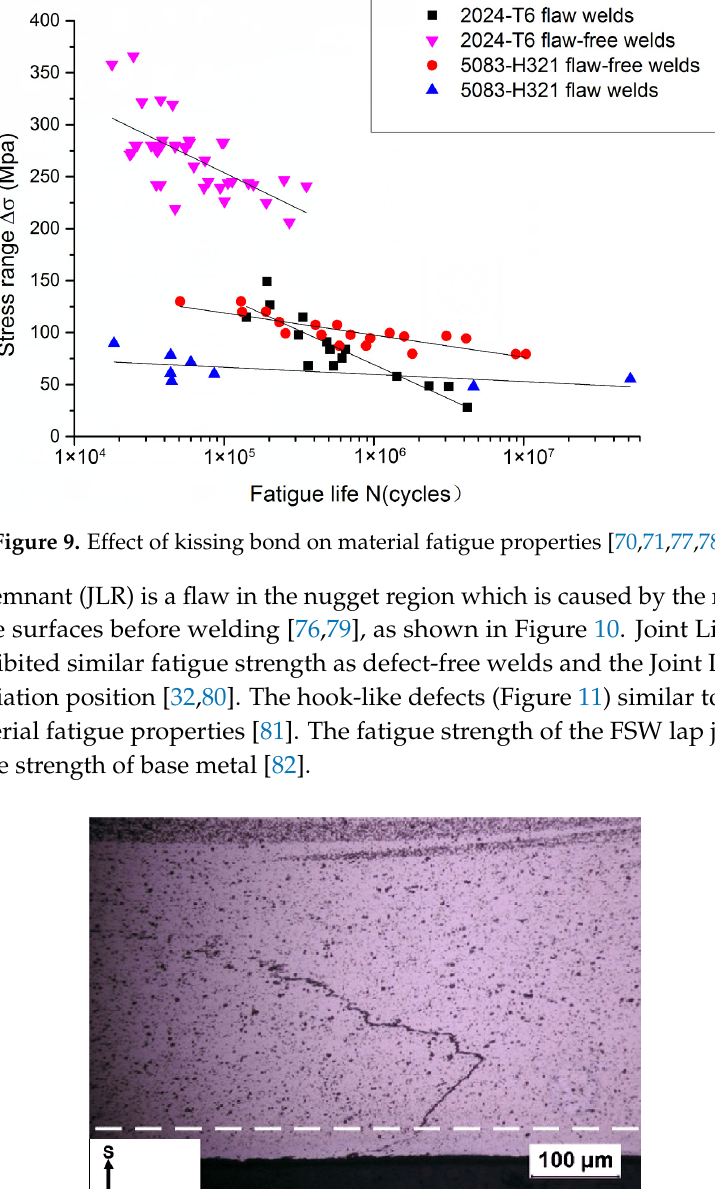
Figure 10. Optical micrograph of a kissing bond (KB)-bearing weld, the dotted line indicates the part of the KB that is removed by grinding of the surface treated specimens [76].